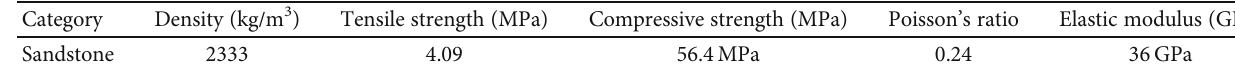
Figure 5: Uniaxial compression test specimen and failure results. Table 1: Physical and mechanical properties of sandstone used in the numerical model.